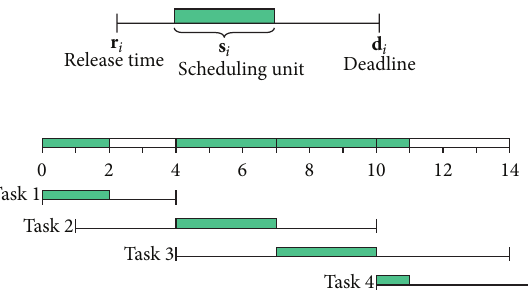
Figure 4: A real-time task scheduling